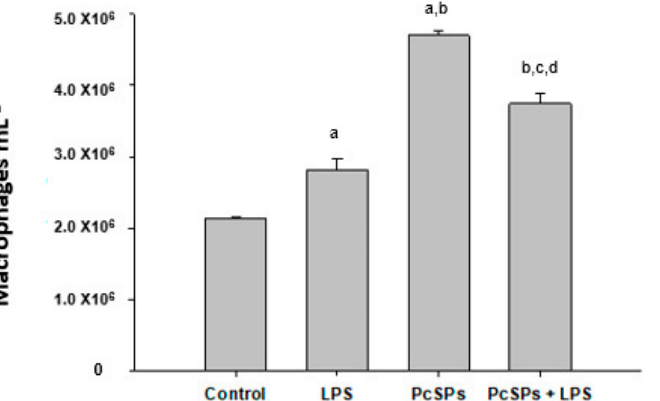
Figure 6 . Effects of PcSPs administration on peritoneal murine macrophages counted after treatment. The bars indicate the mean ± SEM ( n = 6 animals per group). Differences between groups were evaluated using one-way ANOVA and Boferroni’s multiple comparisons test: (a) p < 0.01 and (b) p < 0.001 vs. CONT group, (c) p < 0.001 vs. LPS group and (d) p < 0.001 vs. PcSPs group.